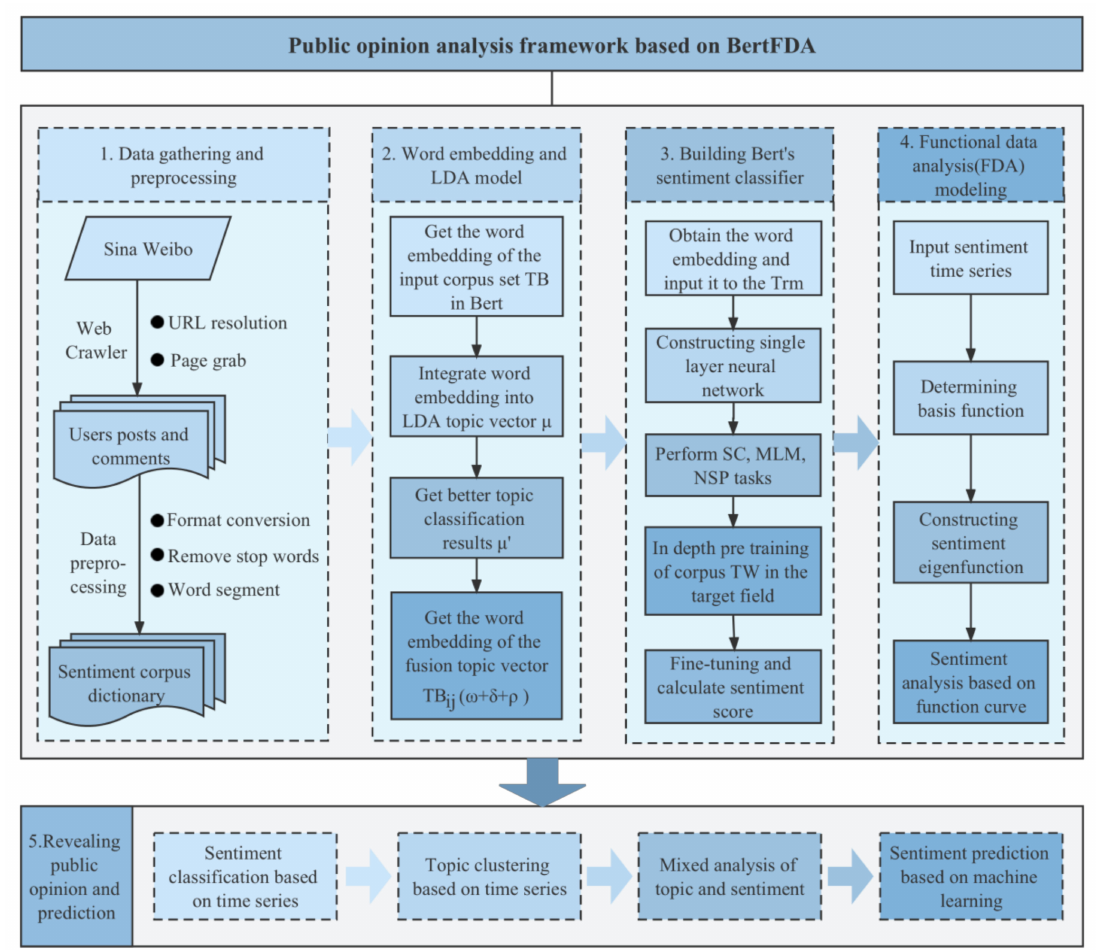
Figure 4. Public opinion analysis framework based on